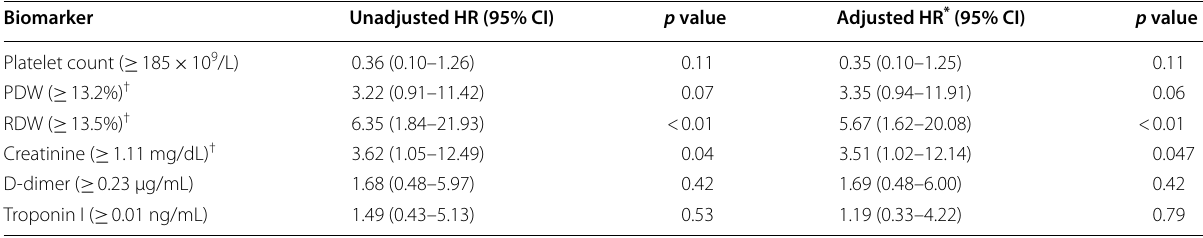
Biomarkers were converted into binary variables based on the optimal cutoff using maximal log-rank statistics CI confidence interval; HR hazard ratio; PDW platelet distribution width; RDW red cell distribution width *Adjusted for anticoagulant use and CHA 2 DS 2 –VASc score † The biomarker with p value < 0.10 was considered as a significant biomarker in prediction of incident ischemic